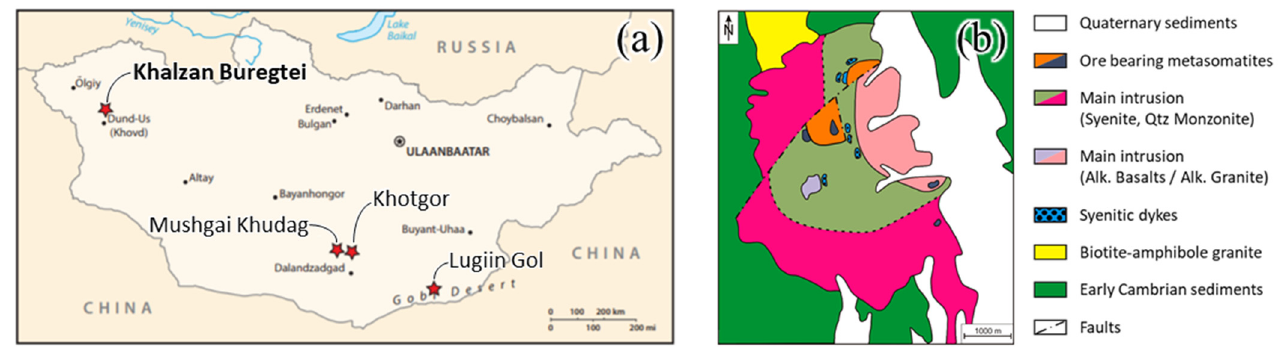
Figure 1. ( a ) A schematic location map of major Mongolian REE deposits (reprinted with permission from Muff and Tamiraa [18]), and ( b ) a geological sketch map of the Khalzan Buregtei deposit (reprinted with permission from Gronen et al. [20]).